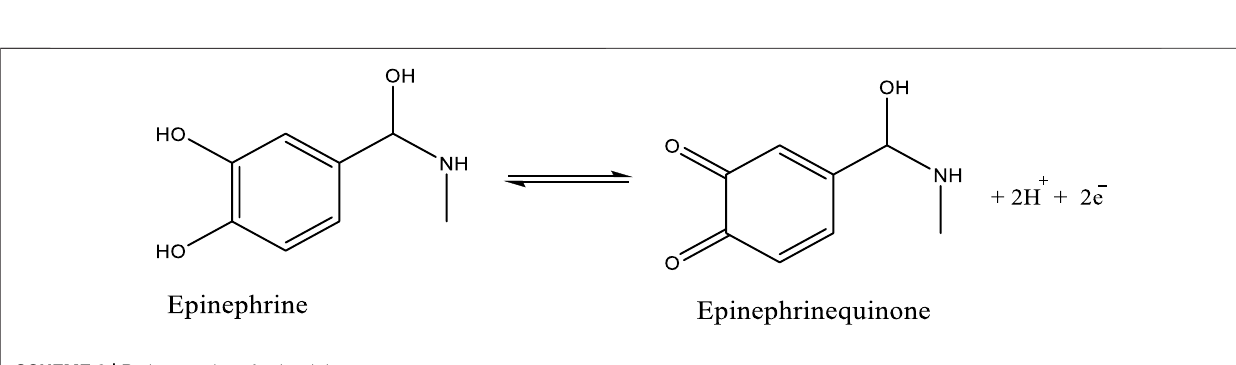
FIGURE 6 | Cyclic voltammogram of Bare SPSE and SPSE/Fe 3 O 4 in (A) 0.1 M PBS (pH 7), and (B) 1 mM EP (pH 7) (scan rate 25 mV s − 1 ).